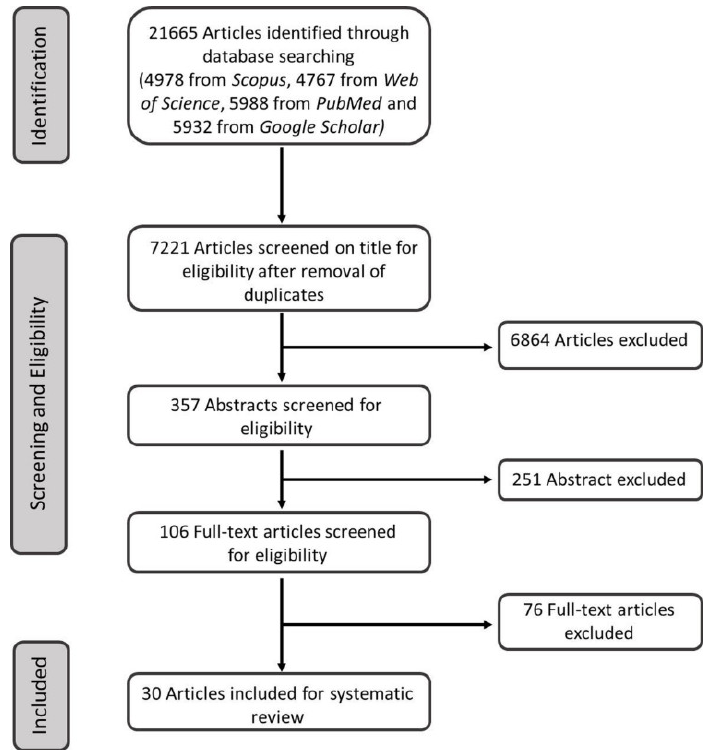
Figure 1. Flow-chart according to the different phases of the systematic review as proposed by PRISMA.